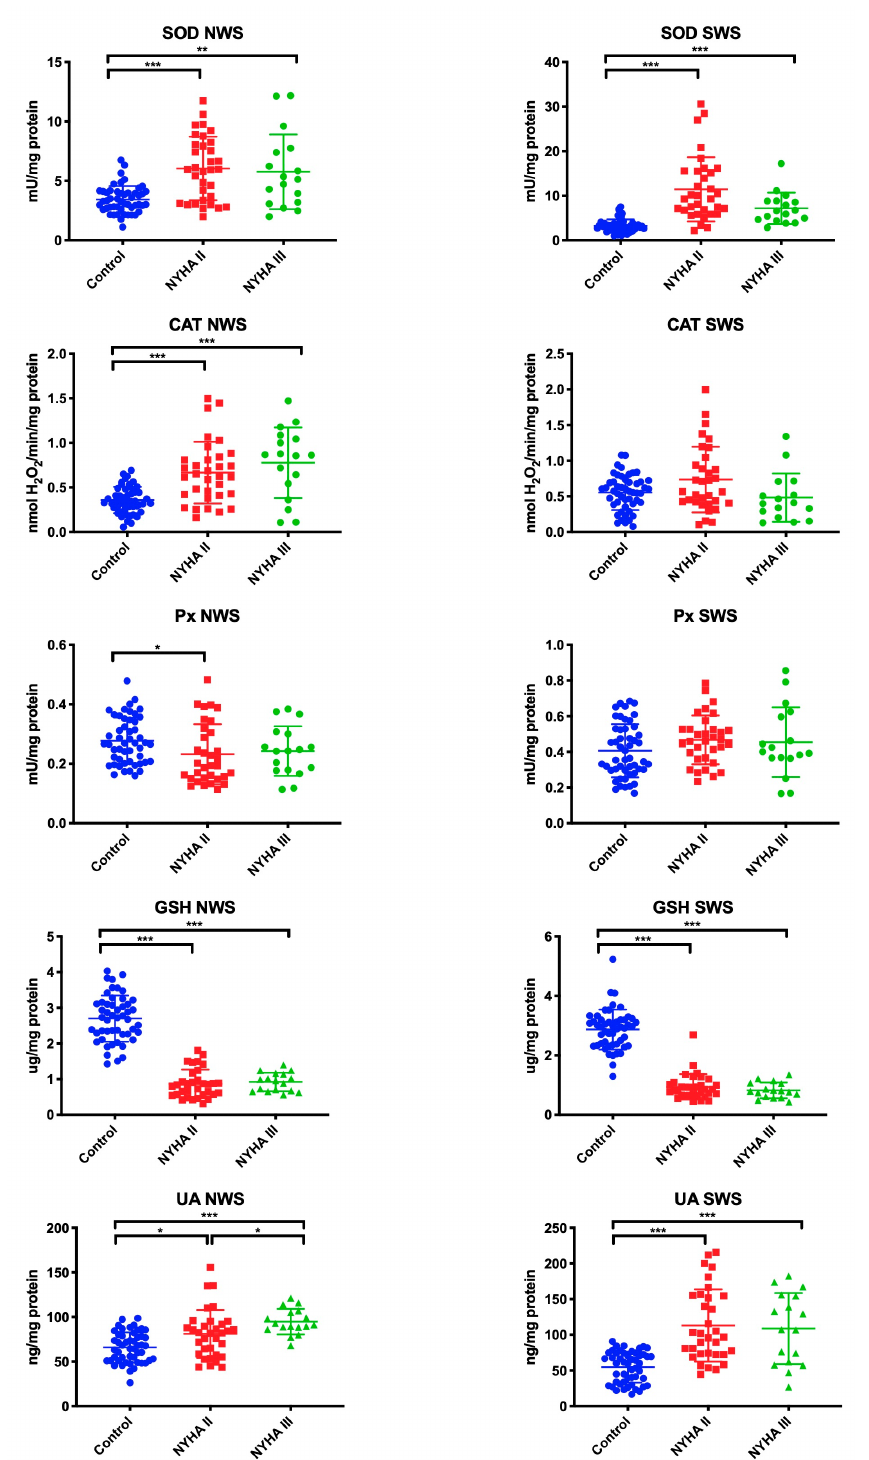
Figure 1. Enzymatic and non-enzymatic antioxidants in non-stimulated and stimulated of HF patients and the control group. Abbreviations: CAT—catalase; GPx—glutathione peroxidase; GSH—reduced glutathione; NWS—non-stimulated whole saliva; NYHA II—class II in the New York Heart Association (NYHA) classification of the heart failure; NYHA III—class III in the New York Heart Association (NYHA) classification of the heart failure; Px—salivary peroxidase; SOD—superoxide dismutase-1; SWS—stimulated whole saliva; UA—uric acid. Differences statistically important at: p * < 0.05, ** < 0.01, ***< 0.001.